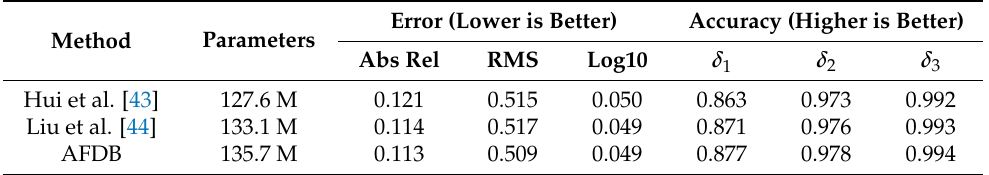
Table 4. The AFDB performance under different settings. Method subscripts show the distillation steps (w/o means without). JAM: joint attention module.